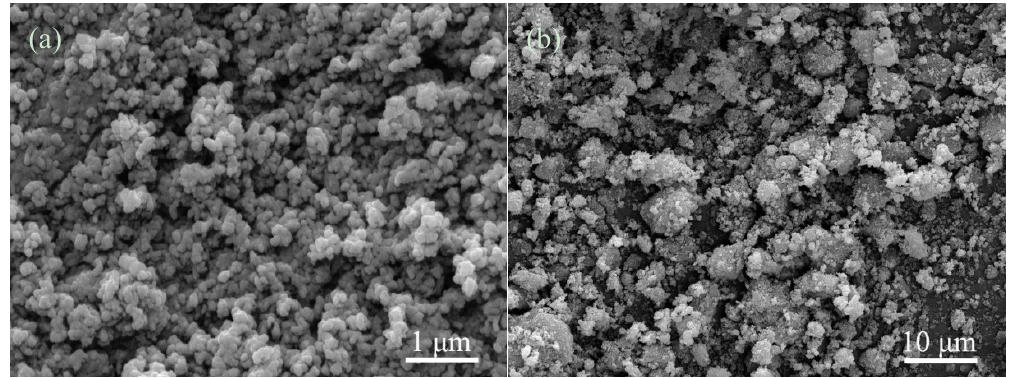
Figure 1. The initial powders: ( a ) hydroxyapatite (HAp); and ( b ) CaO-Al 2 O 3 -SiO 2